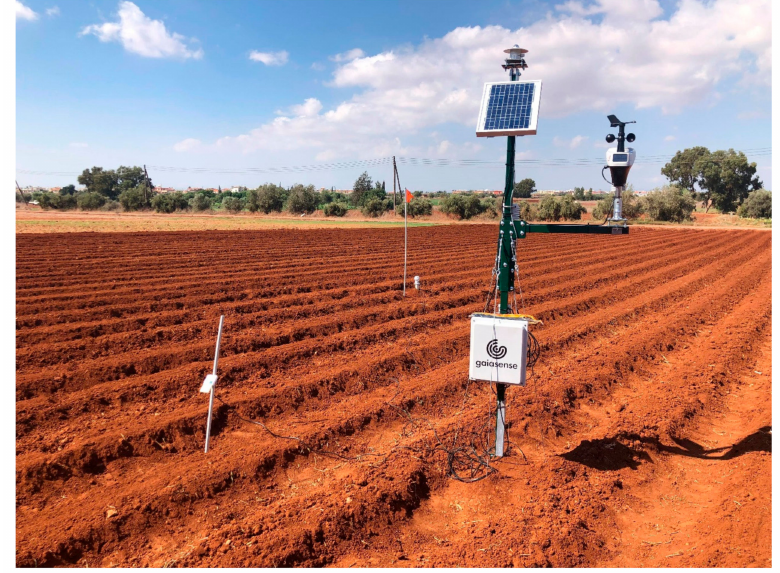
Figure 3. The installation of agro-environmental sensing equipment at the pilot